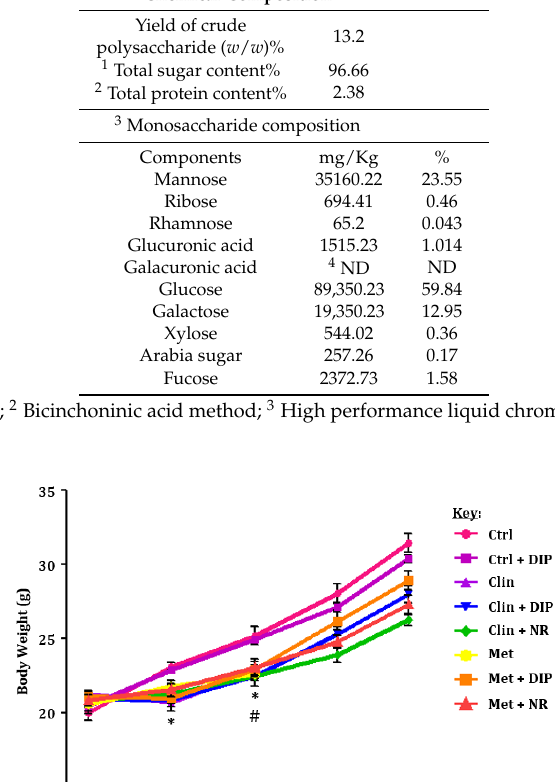
Table 1. Chemical and monosaccharide composition of D. indusiata crude polysaccharide (DIP). Chemical Composition